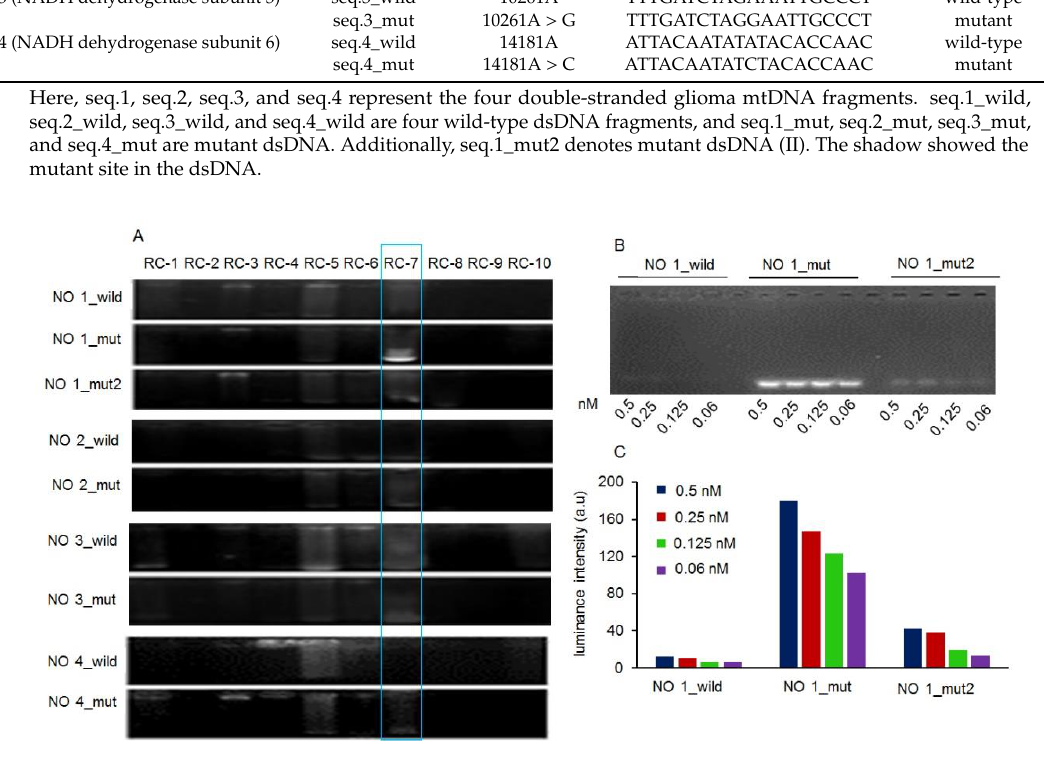
Figure 5. Binding of RCs and mtDNA fragments analyzed by agarose electrophoresis. ( A ) RCs were incubated with wild-type and mutant mtDNA fragments and then subjected to electrophoresis. RC-7 binding is highlighted in the rectangular box. ( B ) RC-7 (10, 5, 2.5, 1.25 nM) binding to wild-type and mutant D-loop mtDNA fragments. ( C ) The fluorescence intensity values of RC-7 binding with the dsDNA fragment containing different mutant sites were determined from three independent experiments, and the mean values were taken.